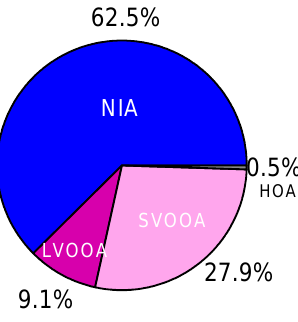
Figure 9. Mass fractions of NO x ions among the PMF factors.